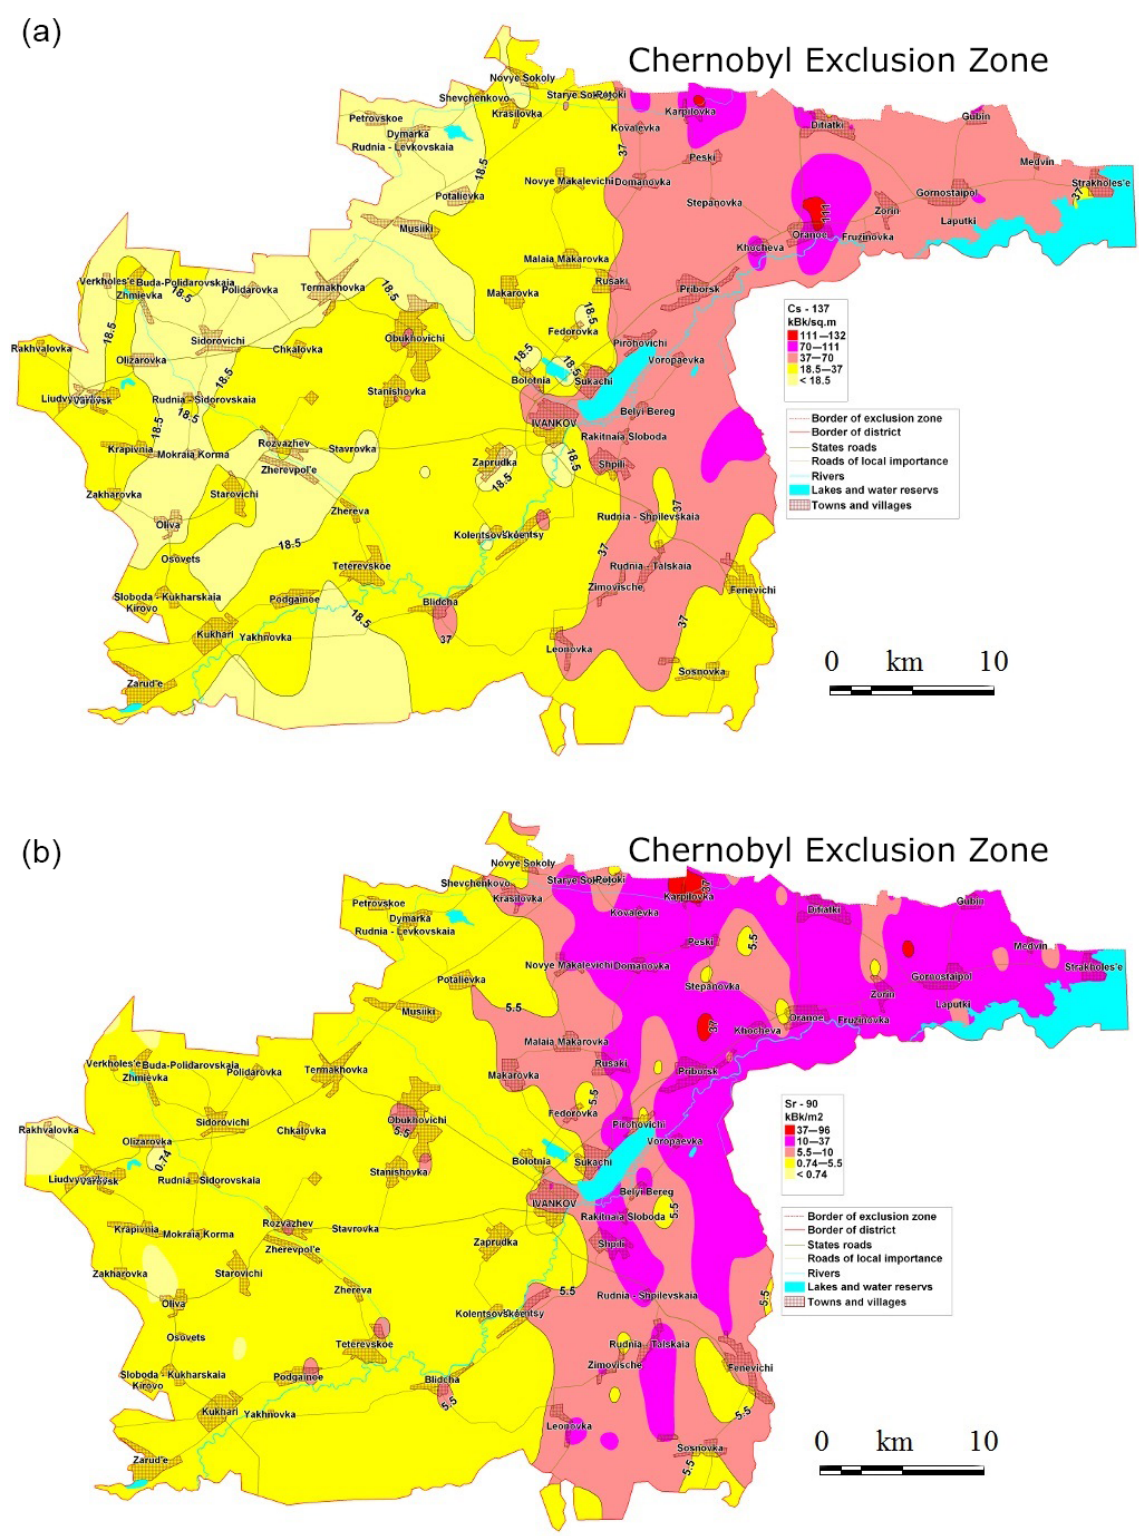
Figure 4. Spatial variation in 137 Cs (a) and 90 Sr (b) soil concentrations (kBqm − 2 ) in the Ivankov district in